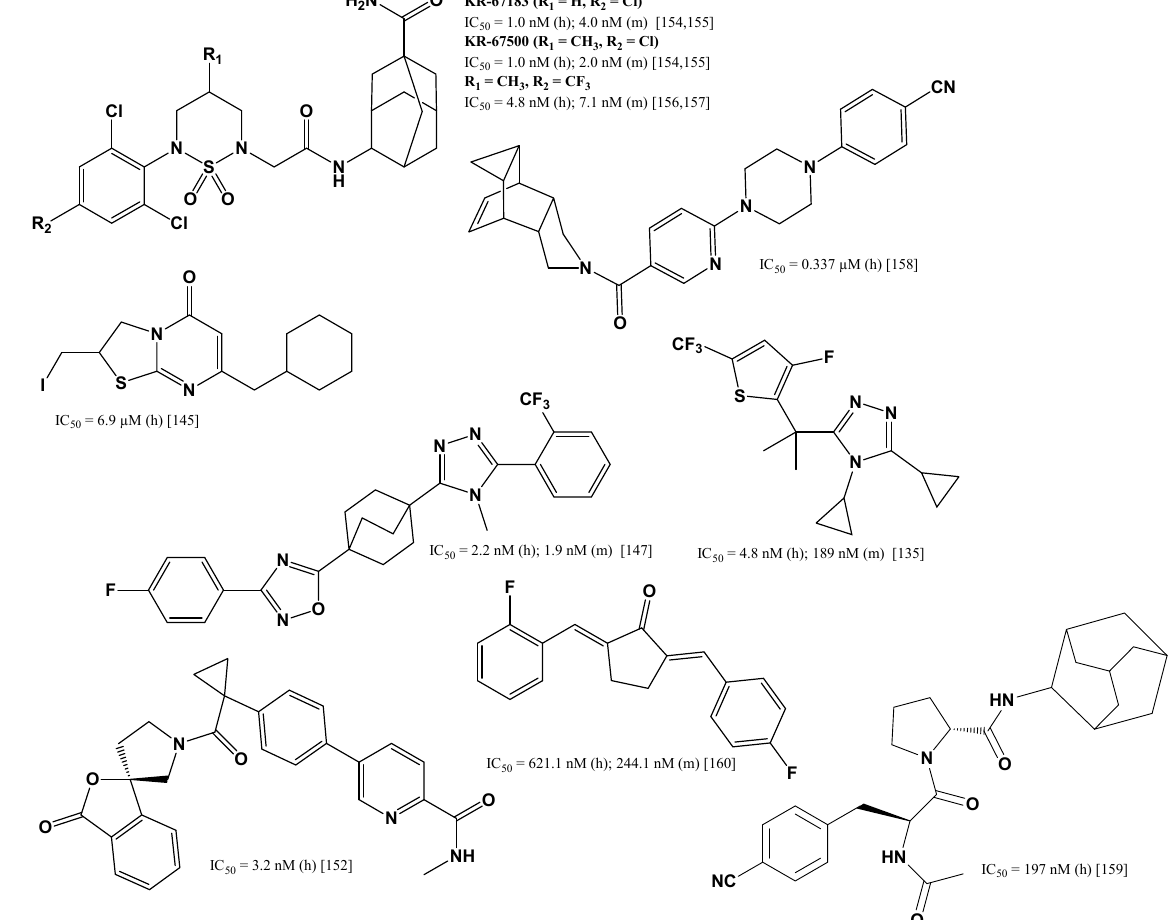
Figure 6. Selected selective 11 β -HSD1 inhibitors with different heterocyclic moiety in in vitro studies. Data refer to tests for human (h) or murine (m) 11 β -HSD1